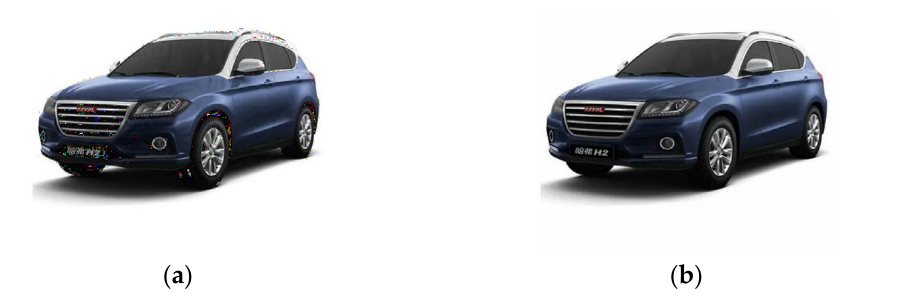
Figure 5. Comparison of the effects of unclip and clip function on adversarial perturbation generation. ( a ) Adversarial perturbation without clip function. ( b ) Adversarial perturbation with clip function. Careful identification of the two images will reveal that colorful noise can be clearly seen in the light-colored part of the car in ( a ). The perturbation information is also present in the dark part, but it is covered by the body color. By superimposing the adversarial perturbations processed by the function into the images, a more hidden adversarial example can be